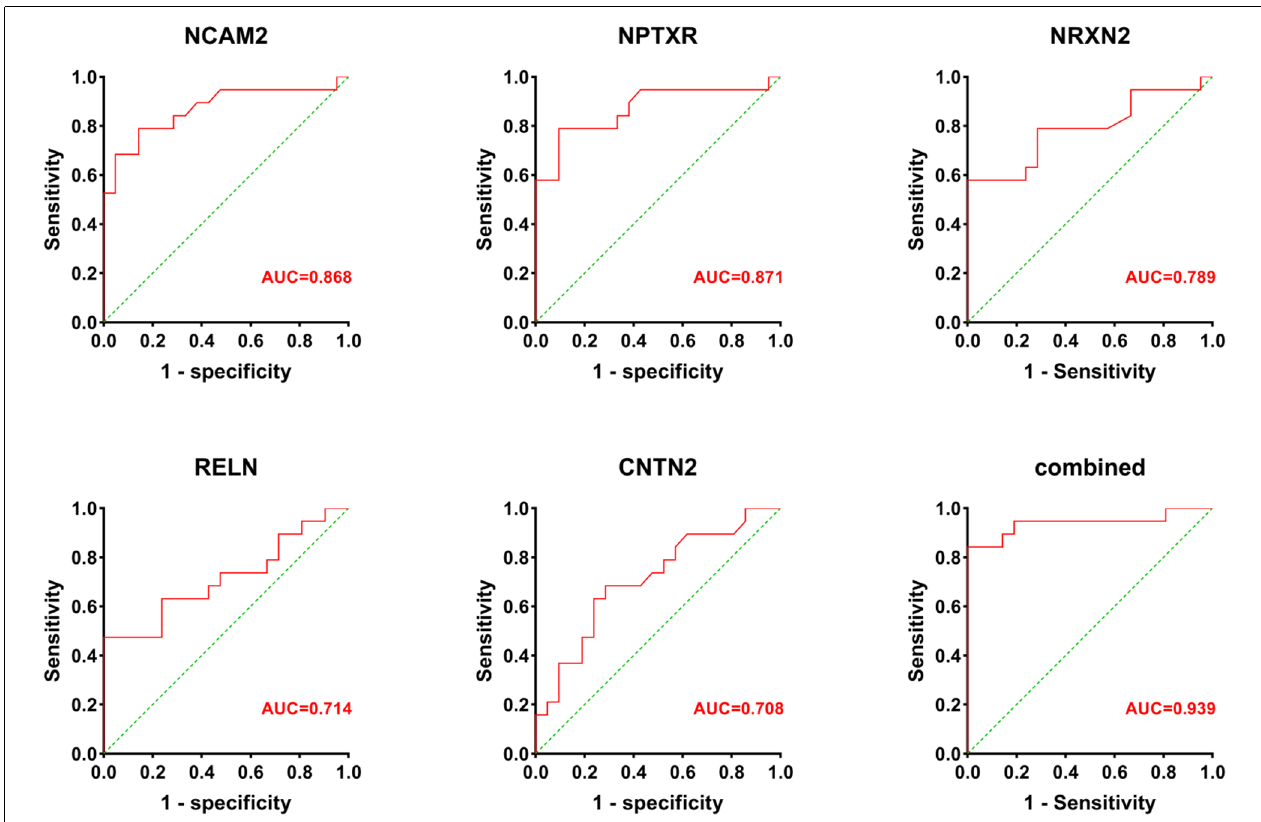
FIGURE 6 | The AUC values (red numbers) of candidate biomarkers in ROC curve analysis. The combination of the five proteins had a stronger predictive value than any of the individual proteins.